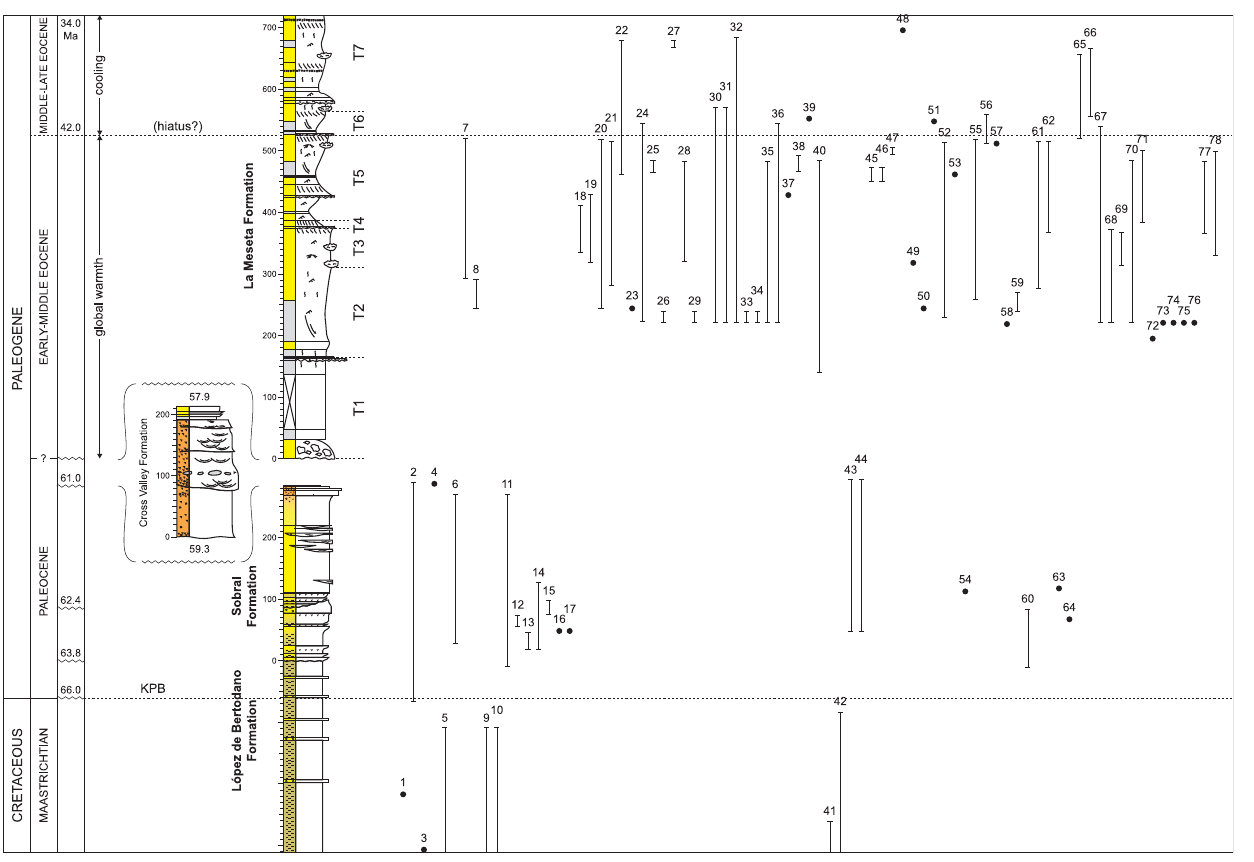
Figure 3. The stratigraphical radiation of the Neogastropoda in Antarctica. Solid lines and dots depict actual fossil occurrences and ranges of 80 neogastropod species. Full details as to how the occurrences and ranges were established within the stratigraphic framework are contained within the text and S2 Appendix. Klb 9 represents the topmost Maastrichtian stratigraphic unit of the LBF, KPB 5 Cretaceous/Paleogene boundary, and (10) is Kplb 10, the recovery interval and topmost informal stratigraphic unit of the LBF. T1–7 5 Telms 1–7 of the LMF; ages (in Ma) are approximate and taken from Montes et al. [117] for the SF, CVF and topmost LMF. Further details on the age of the La Meseta Formation are given in S1 Appendix. Gastropods arranged in taxonomic order according to Bouchet & Rocroi [118]. 1.Heteroterma sp. 2; 2. Heteroterma sp.; 3. Antarctissitys austrodema ; 4. Pyropsis sp.; 5. Taioma charcotiana ; 6. Taioma sobrali ; 7. Taioma bicarinata ; 8. Taioma ? antarctocarinata ; 9. ‘‘Cassidaria’’ mirabilis ; 10. Neogastropod, n. gen. B; 11. Austrosphaera bulloides ; 12. n. gen. woolfei ; 13. ‘‘Colus’’ delrioae ; 14. Probuccinum ? palaiocostatum ; 15. cf. Germonea n. sp.; 16.? Pseudotylostoma pyrinota ; 17. n. gen.? polaris ; 18. ‘‘Penion’’ n. sp. A; 19. ‘‘Penion’’ n. sp. B; 20. Penion australocapax ; 21. Prosipho stilwelli ; 22. Prosipho lawsi ; 23. Prosipho delli ; 24. Prosipho polaris ; 25. Prosipho antarctocosta ; 26. Prosipho n. sp. 1; 27. Prosipho lamesetaensis ; 28. Pareuthria hookeri ; 29. Pareuthria n. sp. 1; 30. Chlanidota antarctica ; 31. Chlanidota tuberosa ; 32. Chlanidota antarctohimaleos ; 33. Chlanidota ? antarctohimaleos ; 34. Chlanidota n. sp. 1; 35. Austroficopsis seymourensis ; 36. Austroficopsis wimani ; 37. Austroficopsis australis ; 38. Austroficopsis austrinus ; 39. Austroficopsis meridionalis ; 40. n. gen. verrucosa ; 41. Neogastropod, n. gen. A; 42. Cryptorhytis philippiana ; 43. Microfulgur binodosa ; 44. Paleopsephaea ? nodoprosta ; 45. Fusinus ? doylei ; 46. Microfulgur byrdi ; 47. Fusinus ? eonodatus ; 48. Fusinus ? suraknisos ; 49. Fusinus ? graciloaustralis ; 50. Trophon radwini ; 51. Eupleura suroabdita ; 52. Turbinellidae indet.; 53. Fulgurofusus brecheri ; 54. Miomelon ? sp.; 55. Adelomelon fordycei ; 56.? Adelomelon suropsilos ; 57. Odontocymbiola amundseni ; 58. Miomelon antarctica ; 59. Tractolira n. sp.; 60. Volutomitra ? antarctmella ; 61. Volutomitra ? cernohorskyi ; 62. Volutomitra ? iredalei ; 63. Marshallaria ? sp.; 64.? Cosmasyrinx (Tholitoma) antarctigera ; 65. Zemacies finlayi ; 66. Aforia canalomos ; 67. Marshallaria ? oliveroi ; 68. Austrotoma n. sp.; 69. Austrotoma ? ventricosa ; 70. Austrosullivania lata ; 71. Austrosullivania striata ; 72. Gemmula askinae ; 73. Spirotropis ? n. sp.; 74. Typhlomangelia ? n. sp.; 75. Agladrillia ? n. sp.; 76. Makiyamaia ? n. sp.; 77.? Splendrillia antarctoliqua ; 78.? Cochlespira brychiosinus ; 79. Pristimercia australis ; 80. Coptostomella ? notopolaris . Species 1–10 unassigned to superfamily; 11–49, Buccinoidea; 50–62, Muricoidea; 63–78, Conoidea; 79–80,